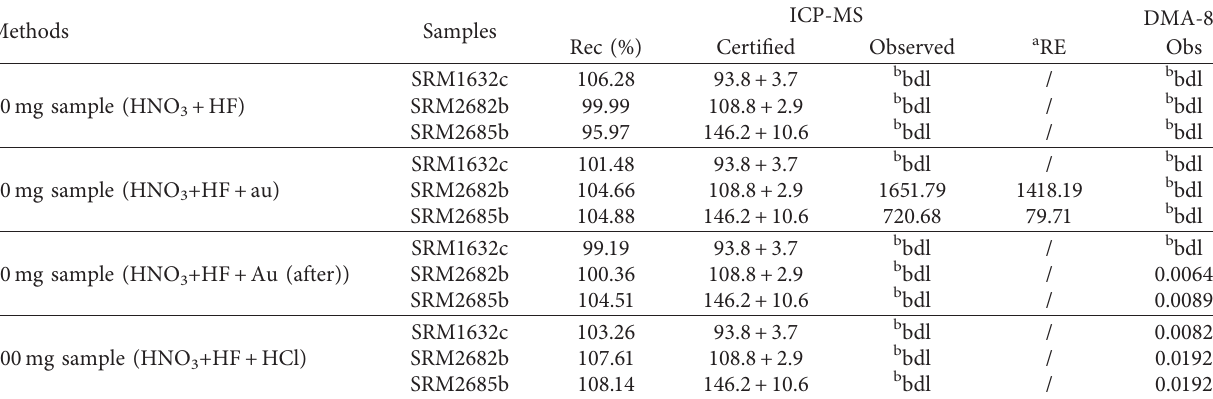
Table 5: Observed and certified values of mercury ( μ g/kg) in the NISTcoal references, as well as internal standard solution recovery (Rec, %) and relative errors (RE, %) of the ICP-MS analysis, and the observed (Obs) values of Hg ( μ g/kg) in the digested solutions measured by the DMA-80 mercury analyzer.